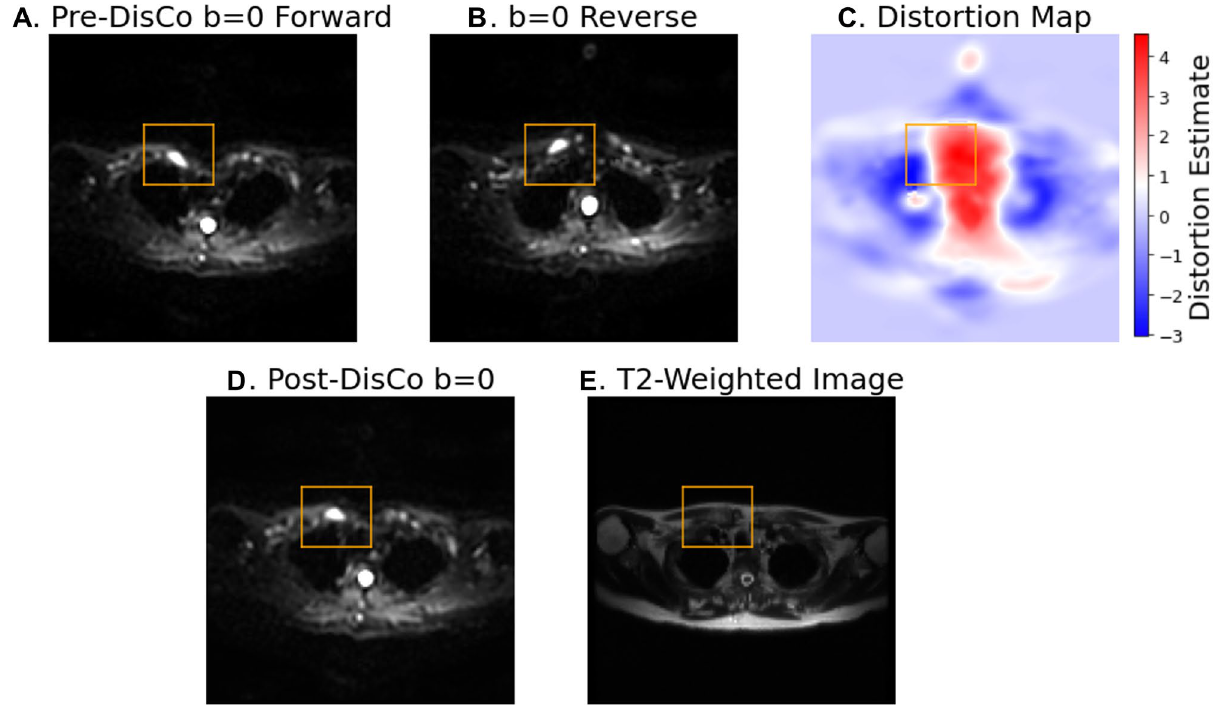
Figure 2. Example bone metastasis illustrating effect of B0 inhomogeneity induced distortion on DWI. In each subfigure, the slice corresponds to the horizontal slice at which the lesion is the largest (see “Methods” section). The orange bounding box was drawn 10 voxels from the lateral edge of the lesion (in DWI space) in each of the 4 directions, then overlaid on the other images. ( A ) DWI b = 0 s/mm 2 image acquired in the forward phase encoded direction. ( B ) DWI b = 0 s/mm 2 image acquired in the reverse phase encoded direction. ( C ) Estimation of the distortion within the slice. Voxel values represent the extent of displacement undergone by each voxel. Red and blue values denote displacement in the posterior and anterior direction, respectively. ( D ) DWI b = 0 s/ mm 2 image after DisCo. ( E ) T2-weighted image at the same slice. DisCo distortion